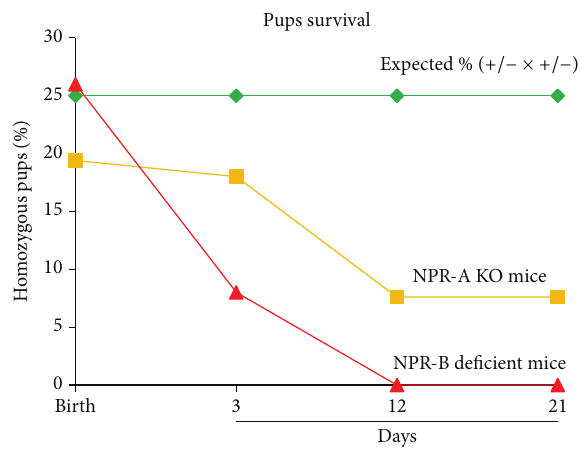
Figure 5: Survival curves of NPR-A KO and NPR-B deficient pups. The results are represented as percentages of the total number of pups ( 𝑛 = 66 for NPR-A KO and 96 for NPR-B deficient mice) obtained in heterozygous breeding (+/ − × +/ − ) and compared to the expected percentages (25%).